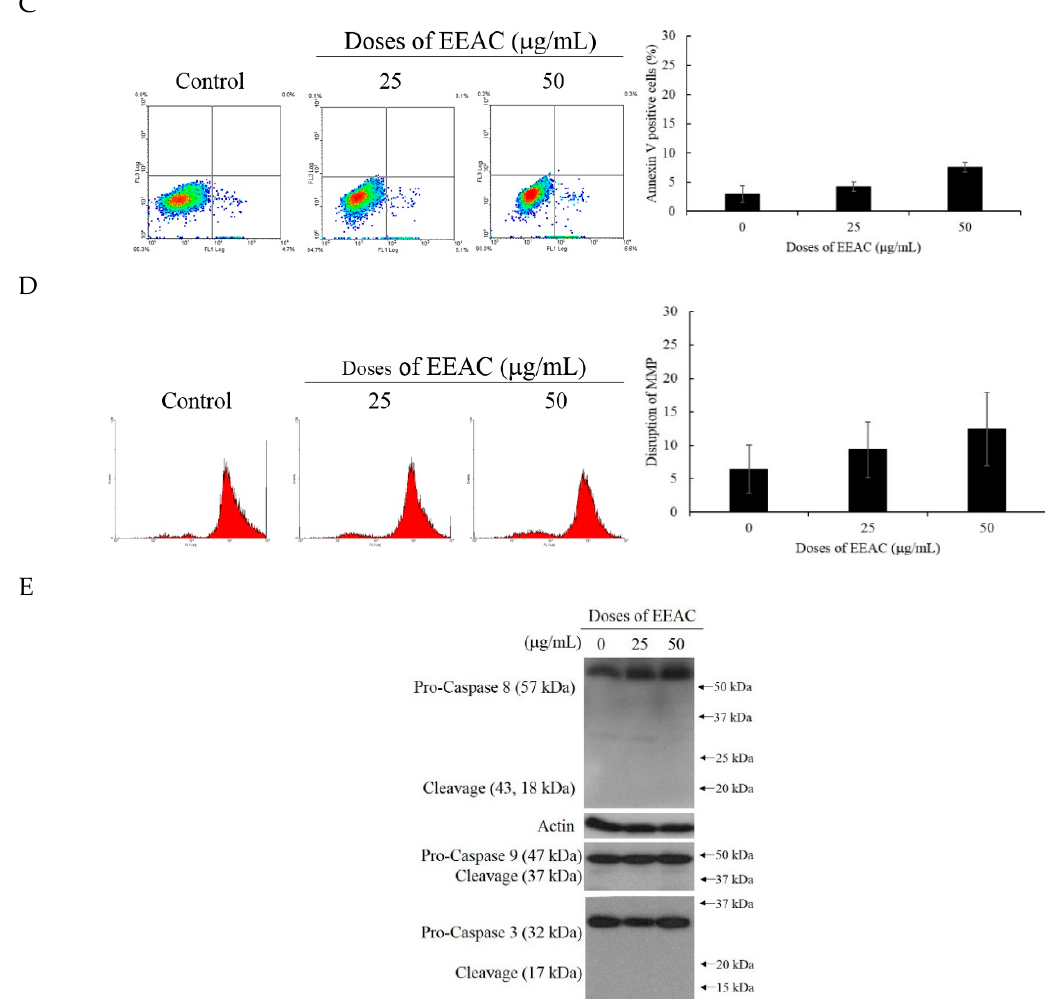
Figure 1. Ethanol extract of artificially cultured AC (EEAC) (25 and 50 µ g/mL) inhibited cancer cell proliferation without the induction of cellular apoptosis and disruption of mitochondrial membrane potential. ( A ) Human cancer cell lines were treated with EEAC and incubated for 72 h and assessed by MTT assay; ( B ) effect of EEAC on colony formation in T47D cells; T47D cells were treated with EEAC, incubated for 48 h, and stained with ( C ) Annexin V and propidium iodide and ( D ) Rhodamine 123; ( E ) the expression of pro-apoptosis protein caspases-3, -8, and -9 was determined by Western blot assay. Actin was used as the loading control. All results are presented as mean ± SD of at least three experiments, ** p < 0.01; *** p < 0.001.